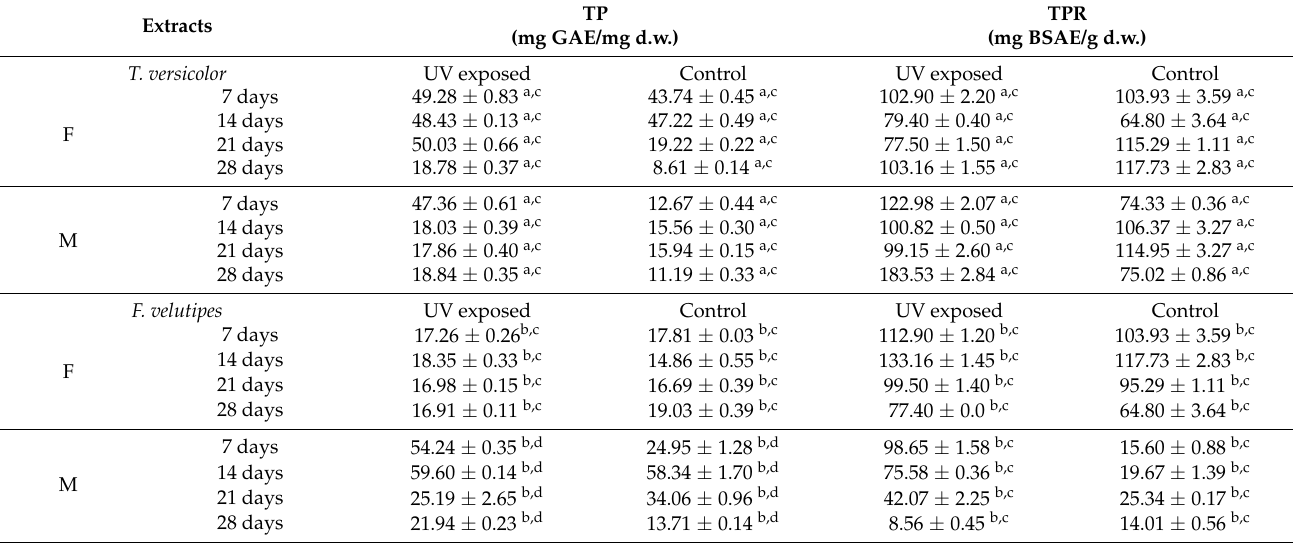
Table 2. Total phenolic (TP) and total protein content (TPR) of EtOH extracts of T. versicolor and F. velutipes . TP (mg GAE/mg d.w.)